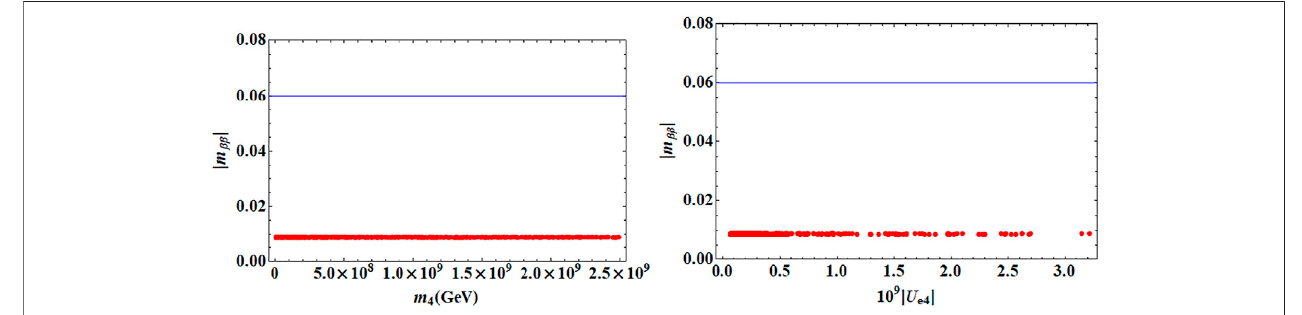
FIGURE 3 | Prediction of the effective neutrino mass as a function of the sterile neutrino mass and mixing.